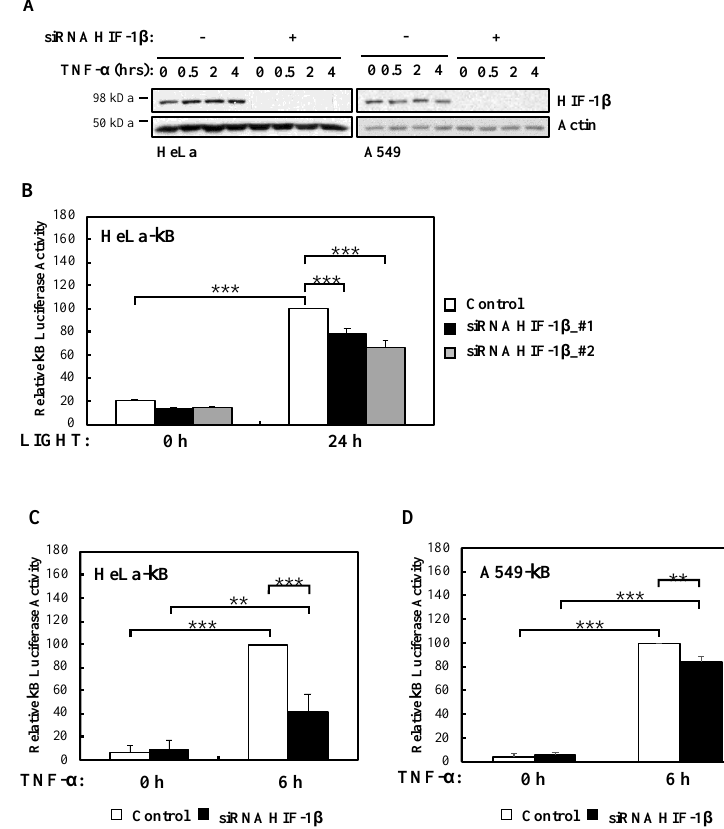
Figure 1. HIF-1 β is required for full NF- κ B reporter gene activity following non-canonical and canonical stimuli. ( A ) HeLa and A549 cells were transfected with control or HIF-1 β siRNA oligonucleotides prior to treatment with 10 ng / mL TNF- α for the indicated periods of time before lysis and Western blot analysis. Actin was used as a loading control. ( B ) HeLa- κ B luciferase cells were transfected with control and HIF-1 β siRNAs for 24 h prior to treatment with 100 ng / mL LIGHT for another 24 h prior to lysis and luciferase activity measurements. All values were normalised to untreated sample. Graph depicts mean and SEM from four independent biological experiments. One way ANOVA analysis was performed and levels of significance was determined as follows: *** p < 0.001. ( C ) HeLa- κ B luciferase cells were transfected as in A , but 10 ng / mL TNF- α was added for 6 h prior to lysis and luciferase measurements. Graph depicts mean and SEM from four independent biological experiments. One way ANOVA analysis was performed and levels of significance are indicated as follows: ** p < 0.01, *** p < 0.001. ( D ) A549- κ B luciferase cells were treated as in 1C . Graph depicts mean and SEM from three independent biological experiments. One way ANOVA analysis was performed and levels of significance determined as follows: ** p < 0.01, *** p < 0.001.